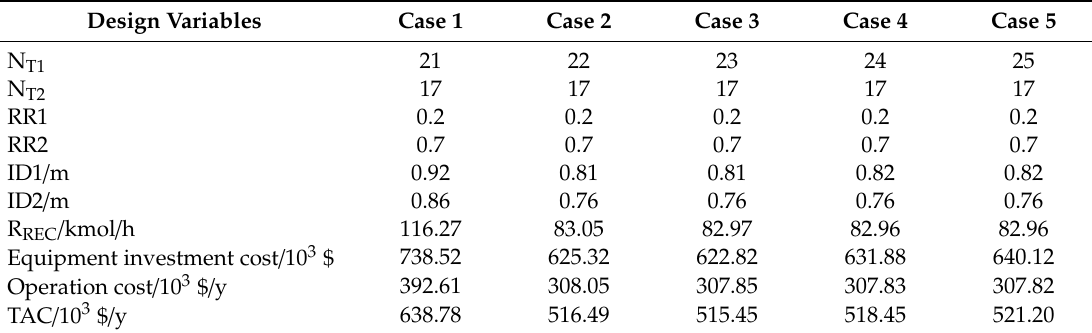
Table 2. Specific results for the tray number of the low pressure column (LPC).